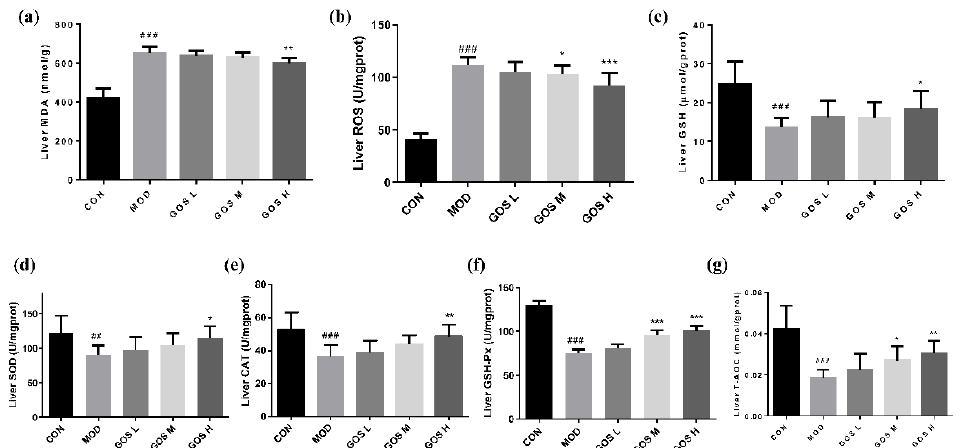
Figure 6. Effects of GOS on the oxidative damage indexes and the activity of antioxidant enzymes in mouse liver ( n = 10, means ± SD). ( a ) Liver MDA. ( b ) Liver ROS. ( c ) Liver GSH. ( d ) Liver SOD. ( e ) Liver CAT. ( f ) Liver GSH-Px. ( g ) Liver T-AOC. Notes: Compared with the MOD group, * p < 0.05,